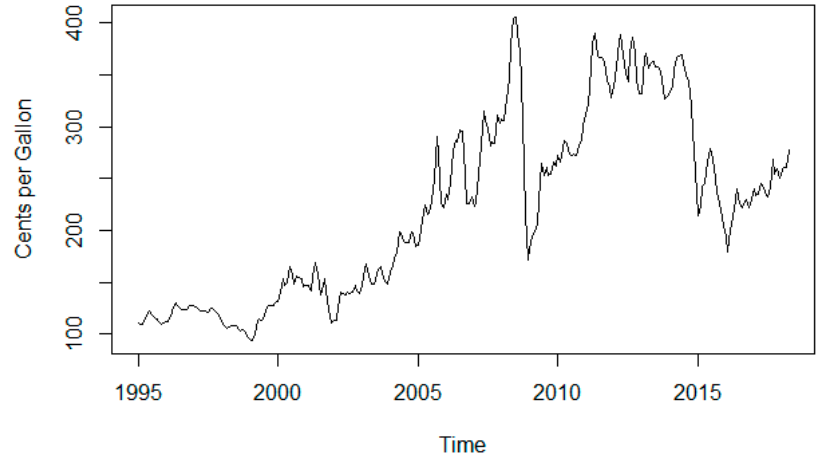
Figure 2. Average retail regular gasoline prices over time illustrate a constant trend with two major corrections (2008 and 2014).